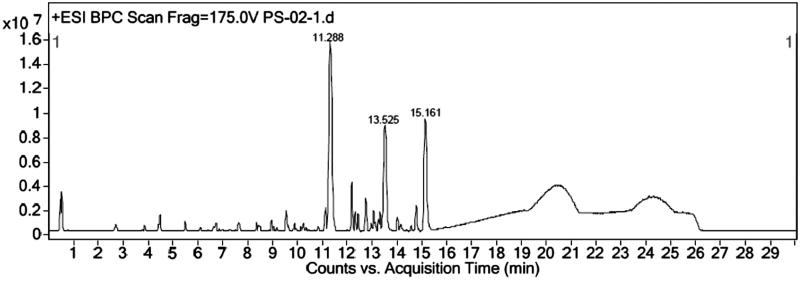
LCMS of PS-02 A.